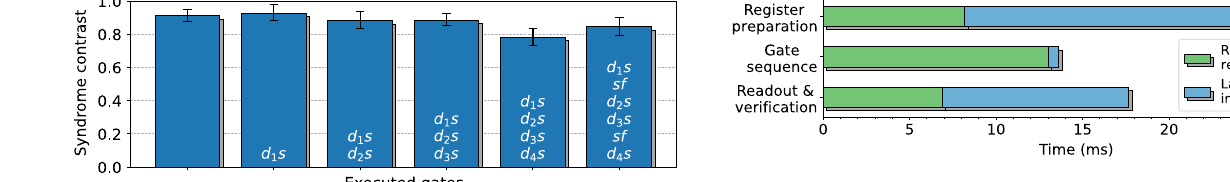
FIG. 8. Timing budget of the FT PCM sequence. The sequence is subdivided into register preparation, the actual PCM gate sequence shown in Fig. 3, and the readout and verification of all qubits. For each block, we show the timing overhead for shuttling operations (green) and laser-driven gate operations